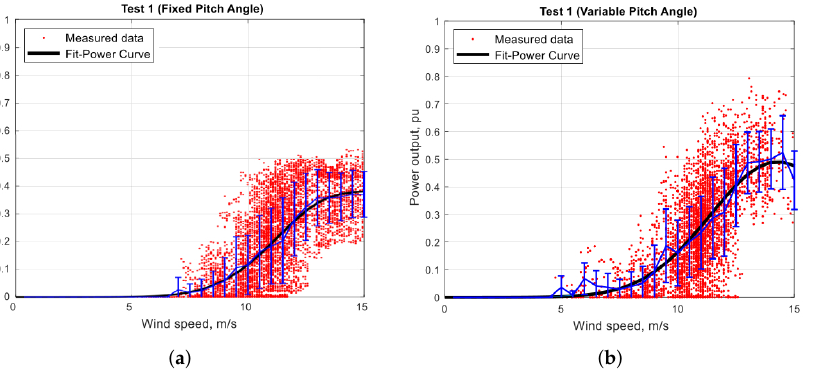
Figure 11. H-type VAWT power generation for the first test: ( a ) fixed pitch angle ( b ) variable pitch